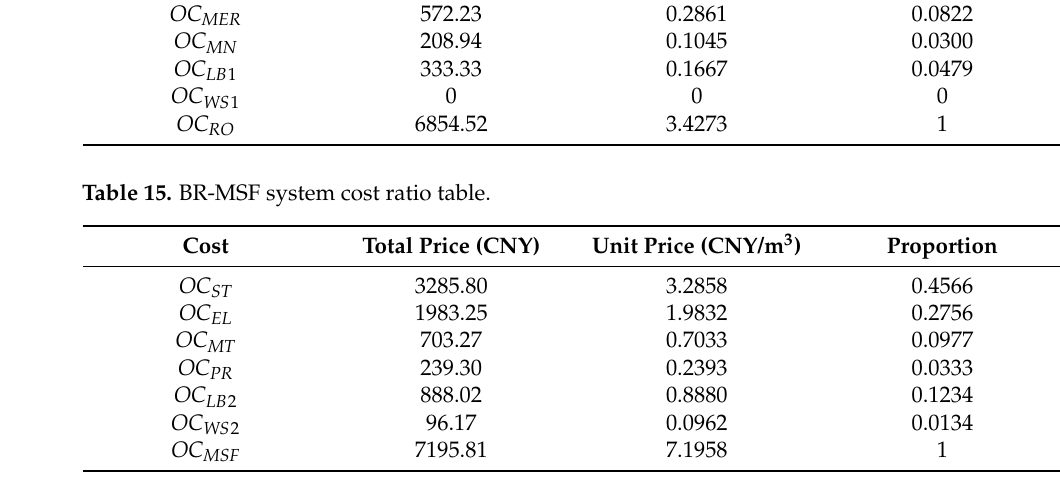
Table 16. Overall water production in option 4.